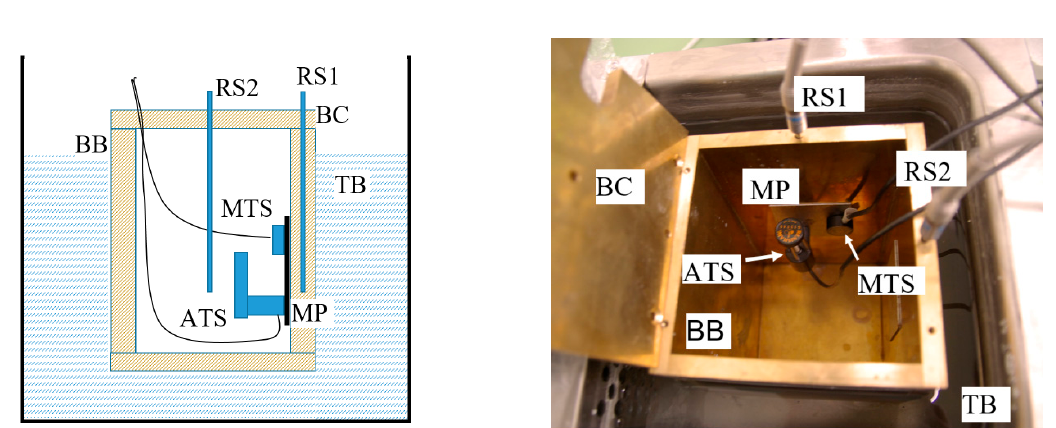
Table 6. Example of a calibration result of a material temperature sensor and the effect on a measured length.